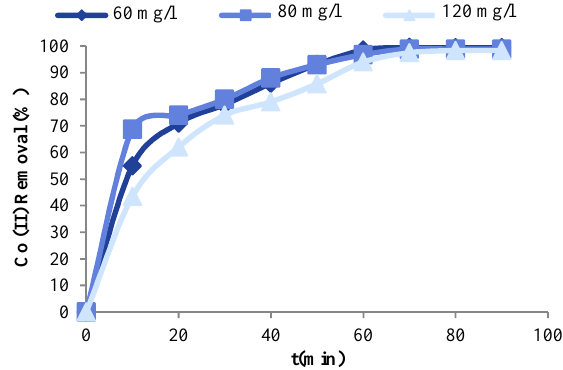
Figure 8. Effect of contact time on the removal efficiency of Co(II) by NiFe (C = 60, 80 and 120 mg/l, solution pH = 7, dose of 0 adsorbent = 0.02 g, and temperature = 25